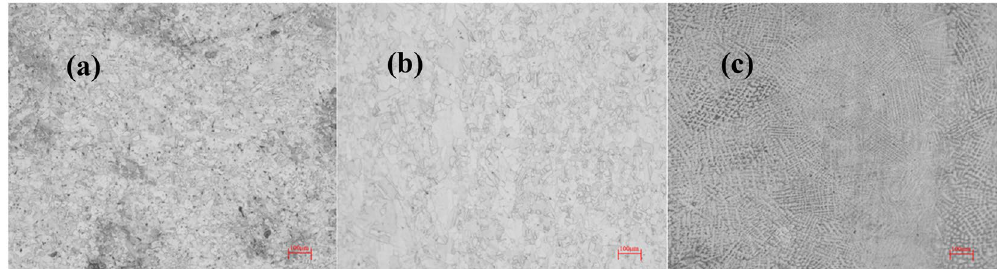
Figure 1. Microstructure of B10 Cu–Ni alloy: ( a ) BM, ( b ) HAZ, ( c ) WM.